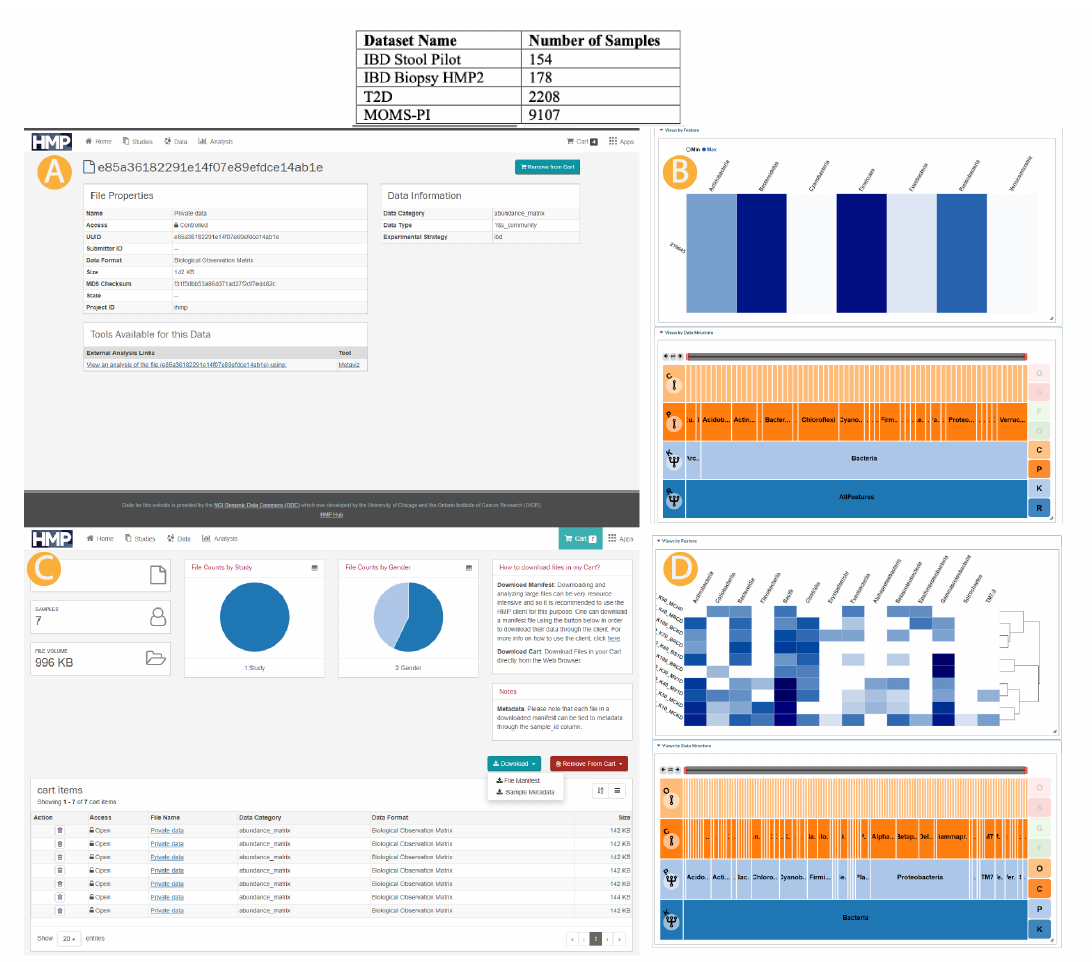
Figure 1. Metaviz and iHMP data infrastructure integration. Top: iHMP data accessible through the UMD Metagenome Browser. Middle ( A , B ): Single sample link from data portal to UMD Metagenome Browser. Bottom ( C , D ): Multiple samples manifest file upload and selection to UMD Metagenome Browser. We provide several mechanisms to access the HMP dataset from Metaviz. First, we loaded the three datasets (IBD, T2D, and MOMS-PI) into the hosted instance of Metaviz directly. A user can choose any of these datasets from the data selections screen then samples can be chosen within each dataset. We also link to the HMP Data Portal for single samples as shown in the Middle panel ( A , B ). Finally, the HMP Data Portal provides a “cart” functionality where a user can select multiple samples and download a manifest listing those files ( C ). A user can upload a manifest file containing selections from the 16S community abundance profiles from the same dataset (IBD, T2D, or MOMS-PI) to the UMD Metagenome Browser and a new Metaviz workspace is created with those files ( D ).